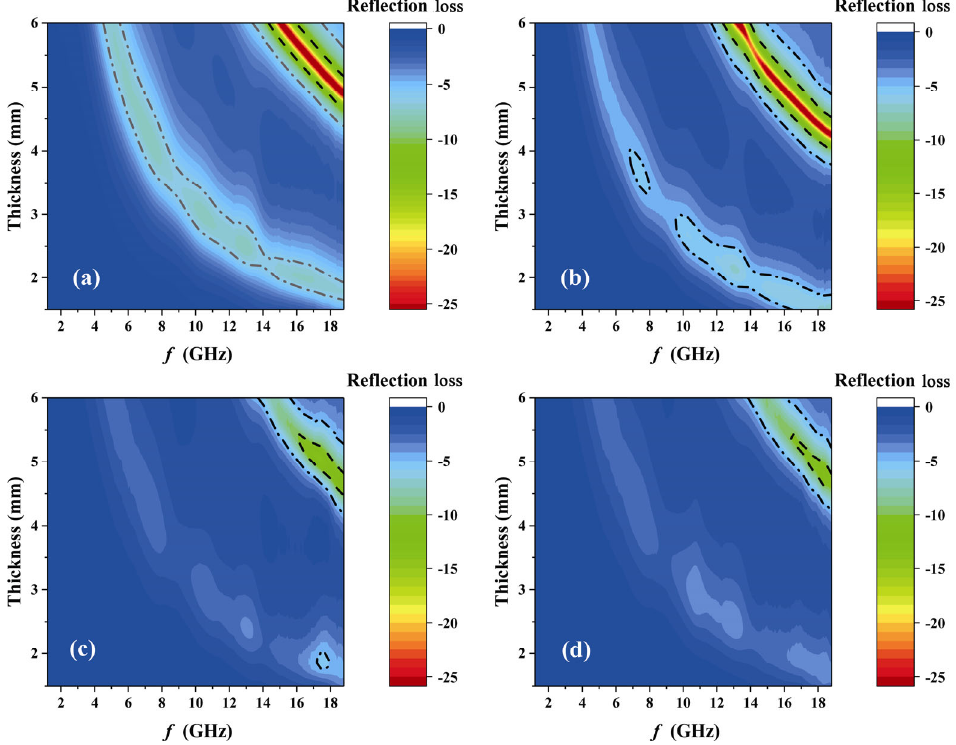
Fig. 6 3D RL contour plots of BFTO- x ceramics: (a) x = 0.2, (b) x = 0.4, (c) x = 0.6, and (d) x =